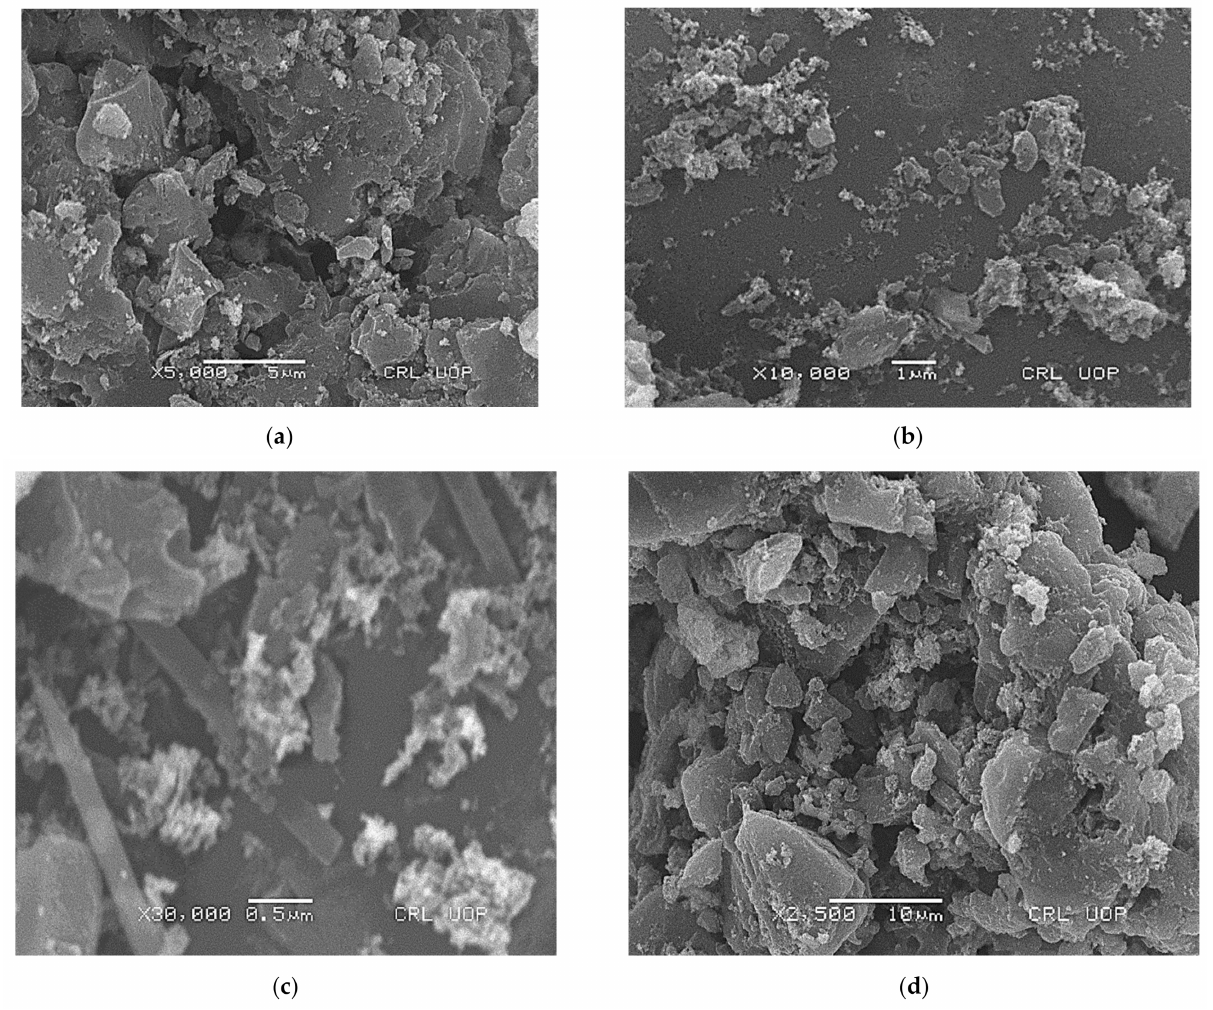
Figure 3. Scanning electron microscope (SEM) images of Pd-Ni/AC-CeO 2 on various resolutions and magnifications of: